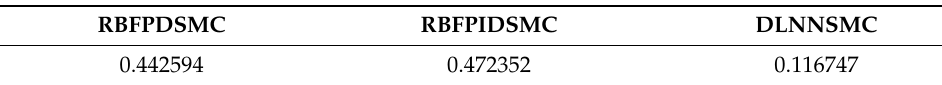
Table 3. Average values of 𝐷